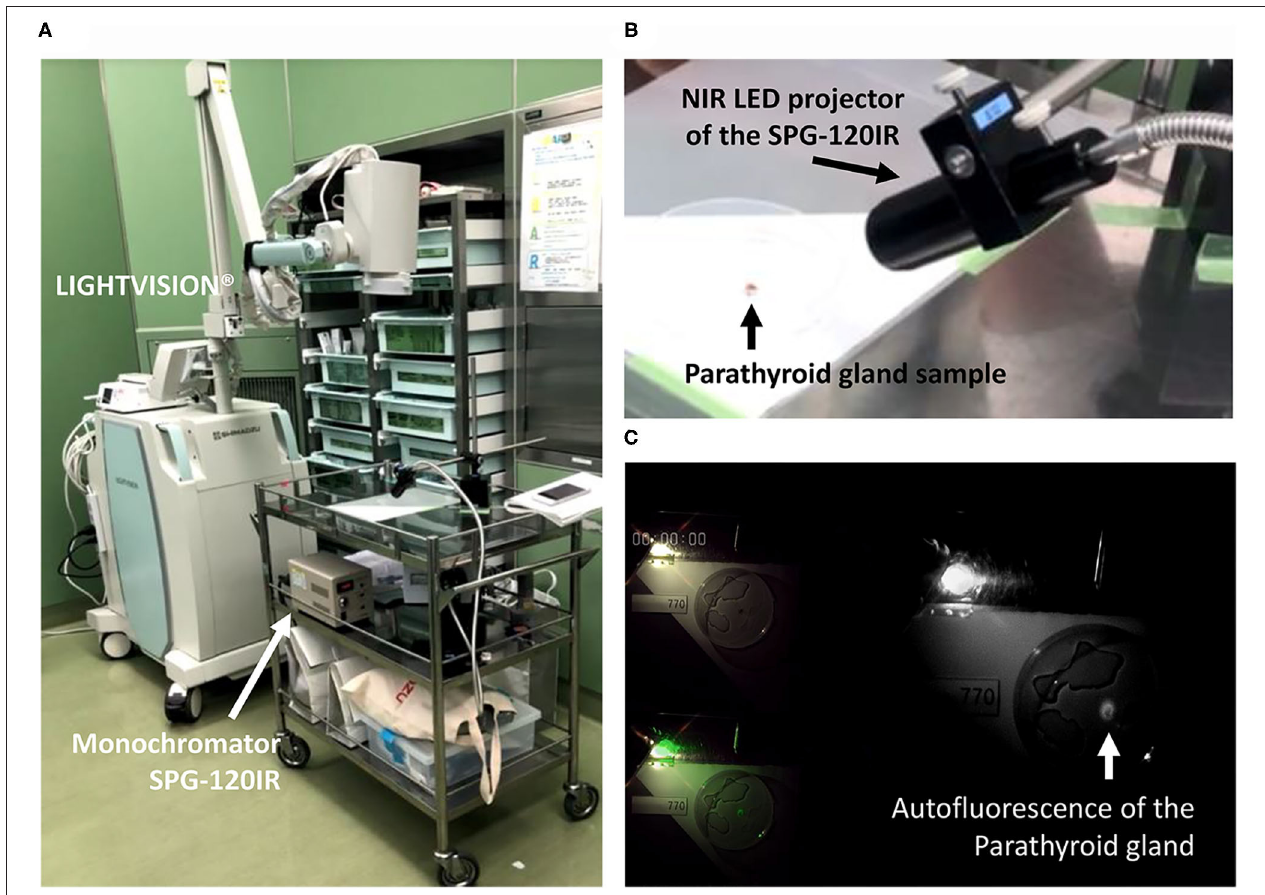
FIGURE 1 | Device used to measure the EWL characteristics of the parathyroid gland : (A) the fluorescence illumination was recorded with the LIGHTVISION NIR camera; (A,B) NIR EWL was projected to the extracted parathyroid gland from the monochromator SPG-120IR; (C) illumination data from the video recorded image were analyzed using ImageJ; the image is lightened by penlight to show the sample and projected EWL nm. EWL, excitation wavelength; NIR, near